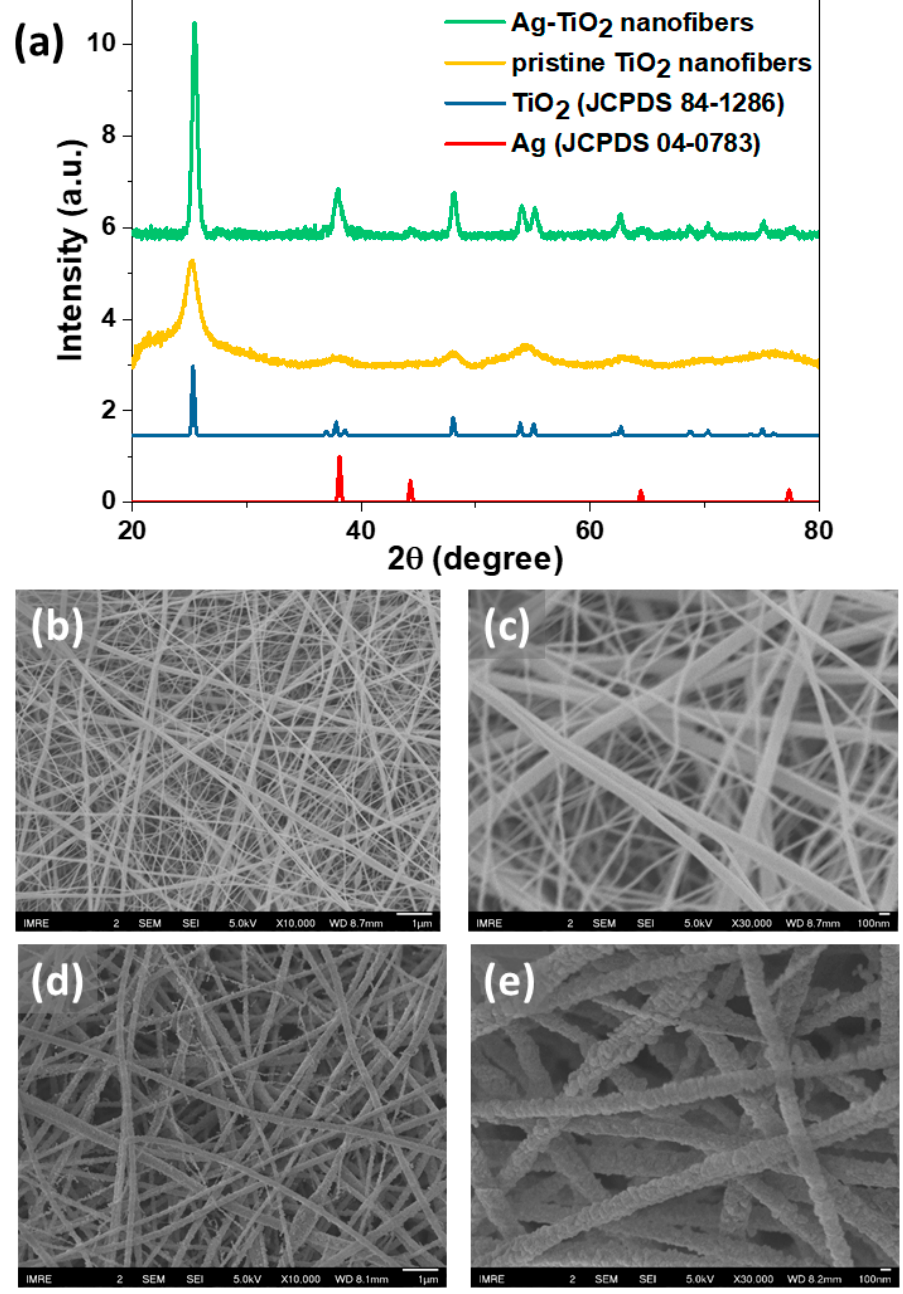
Figure 1. ( a ) XRD patterns for experimental Ag-TiO 2 nanofibers (green) and pristine TiO 2 nanofibers (yellow) alongside literature patterns for TiO 2 (blue) and Ag (red); ( b,c ) SEM images of the pristine TiO 2 nanofibers after calcination at ( b ) 10,000 × and ( c ) 30,000 × resolution; ( d,e ) SEM images of the Ag-TiO 2 nanofibers after calcination at (d) 10,000 × and (e) 30,000 ×